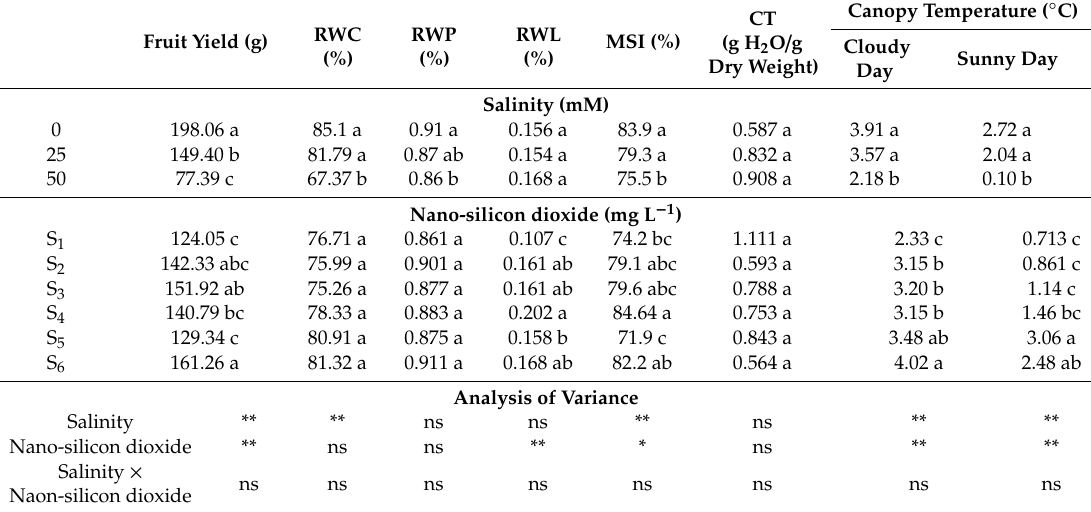
Table 4. E ff ect of nSiO 2 and salt stress on fruit yield, Relative Water Content (RWC); Relative Water Protection (RWP); Relative Water Loss (RWL); Membrane Stability Index (MSI), Cuticle Transpiration (CT) and canopy temperature for strawberry cv